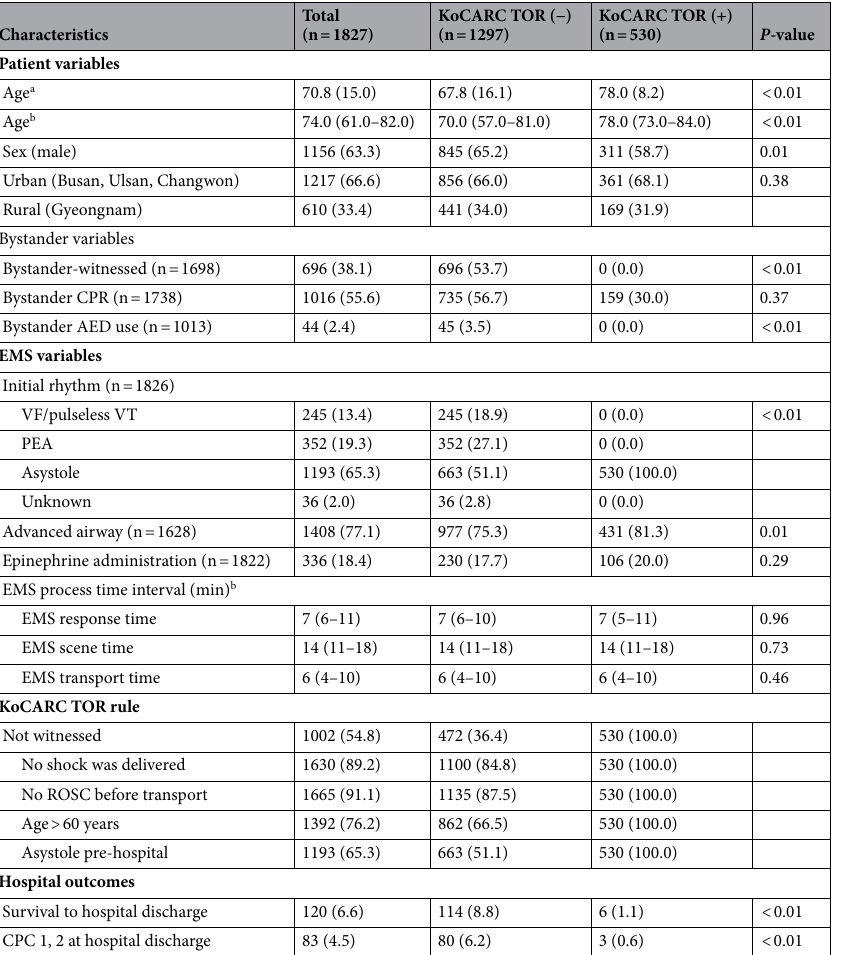
Table 1. Demographics, pre-hospital characteristics, and hospital outcomes of the study population. KoCARC, Korean Cardiac Arrest Research Consortium; TOR, termination of resuscitation; CPR, cardiopulmonary resuscitation; AED, automated external defibrillator; EMS, emergency medical service; VF, ventricular fibrillation; VT, ventricular tachycardia; PEA, pulseless electrical activity; ROSC, return of spontaneous circulation; CPC, cerebral performance category. Variables are presented as the mean ± standard deviation a , median (quartile 1-quartile 3) b , and number